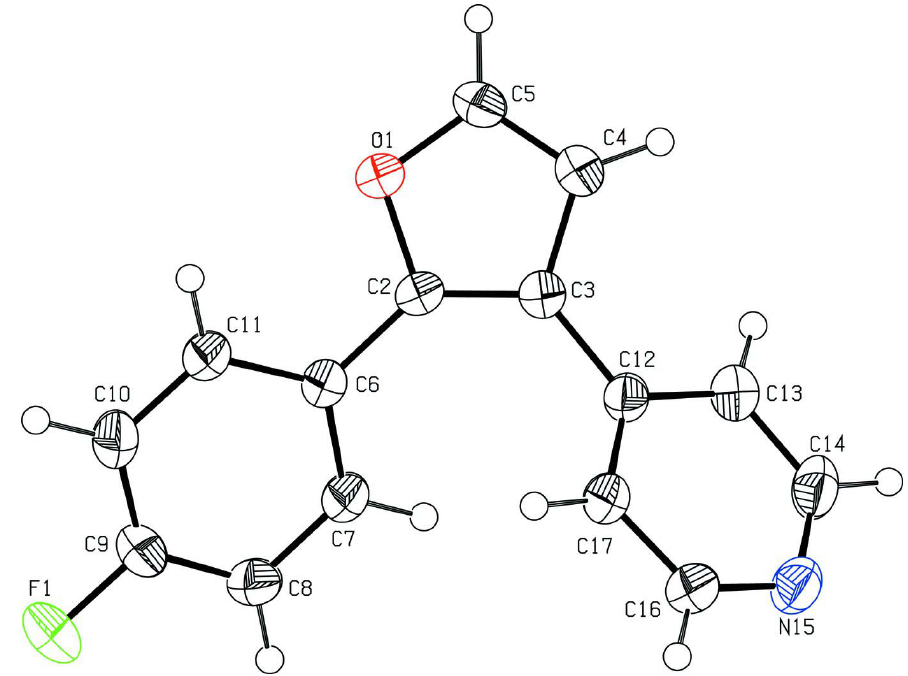
Figure 1 View of the title compound. Displacement ellipsoids are drawn at the 50% probability level. H atoms are depicted as circles of arbitrary